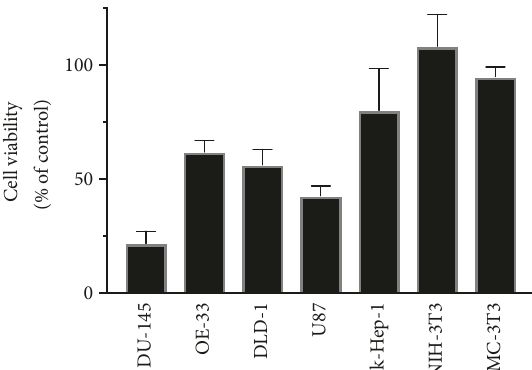
Figure 8: Differential sensitivity of cancer cell lines and nontumorigenic cell lines to 4,5-diCQA . The cell lines were cultured in their respective media as described in Section 2.6. Cultures were dissociated using trypsin and cells were plated in 96-well plates (5000 cells/well). After 24 hours, cells were treated with 5 𝜇 M concentration of 4,5-diCQA in the growth medium. After 72 hours of treatment, cell viability was ascertained by the CCK-8 assay. Untreated cultures served as controls. Mean ± standard deviation of triplicates is